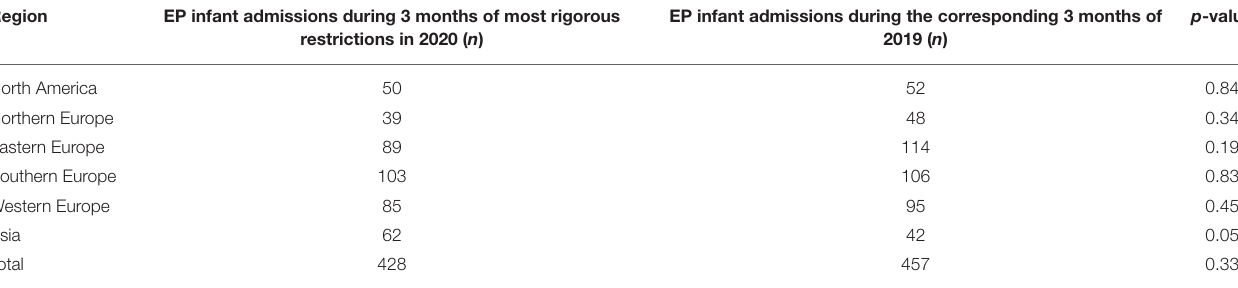
TABLE 2 | EP infant admissions in 2020 and 2019 within each pre-defined geographic region.